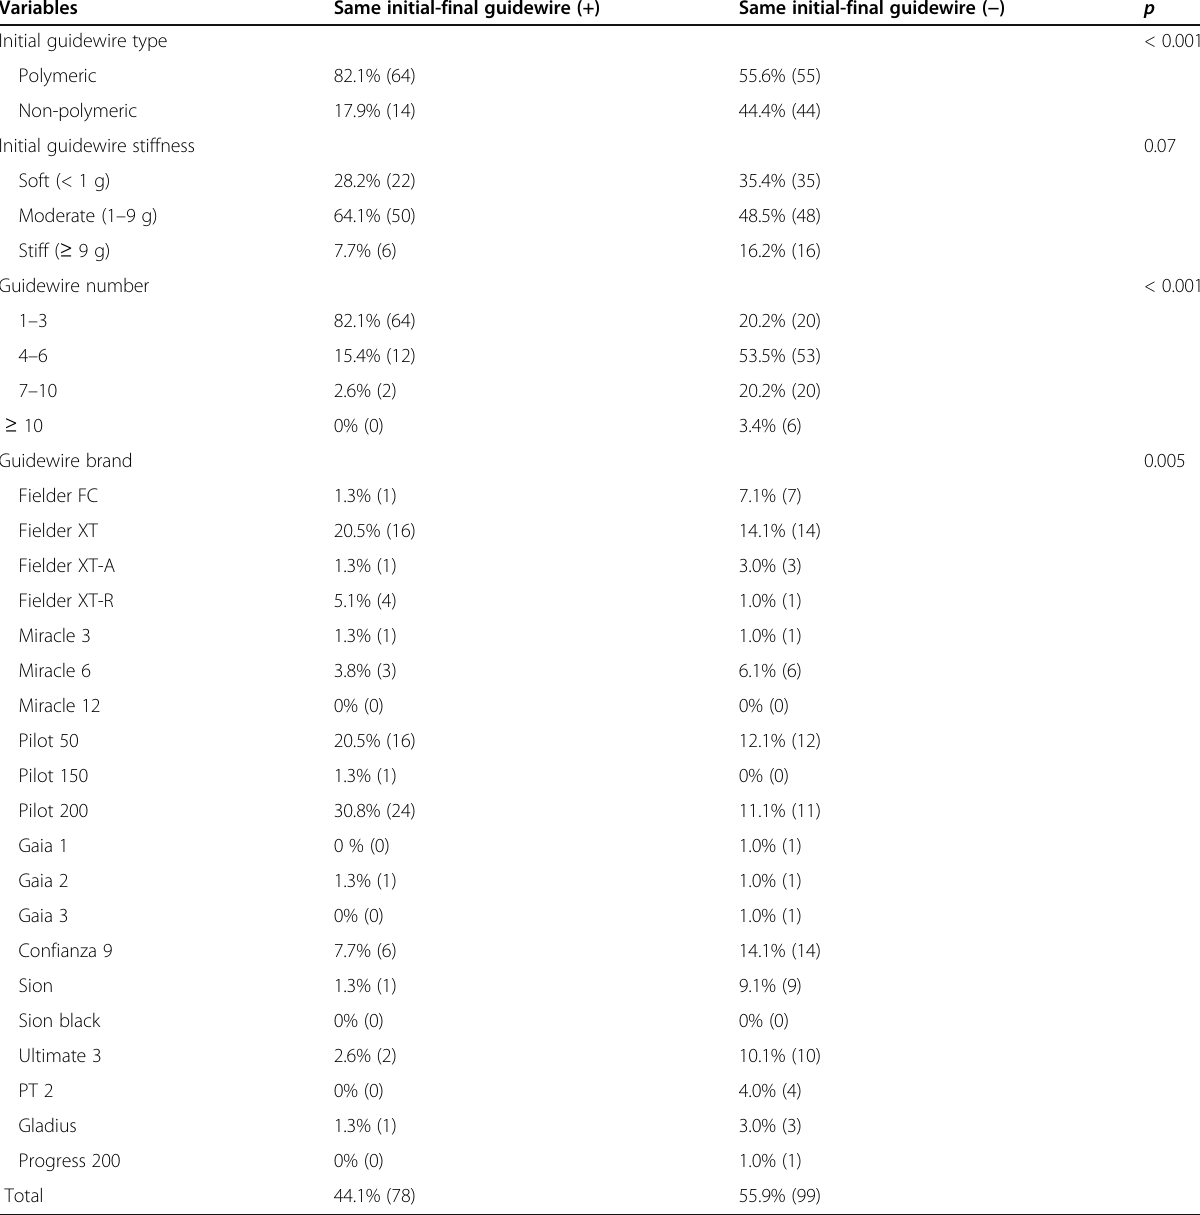
Table 4 Distributions of guidewire type, number, and brands according to crossability of initial choice guidewire